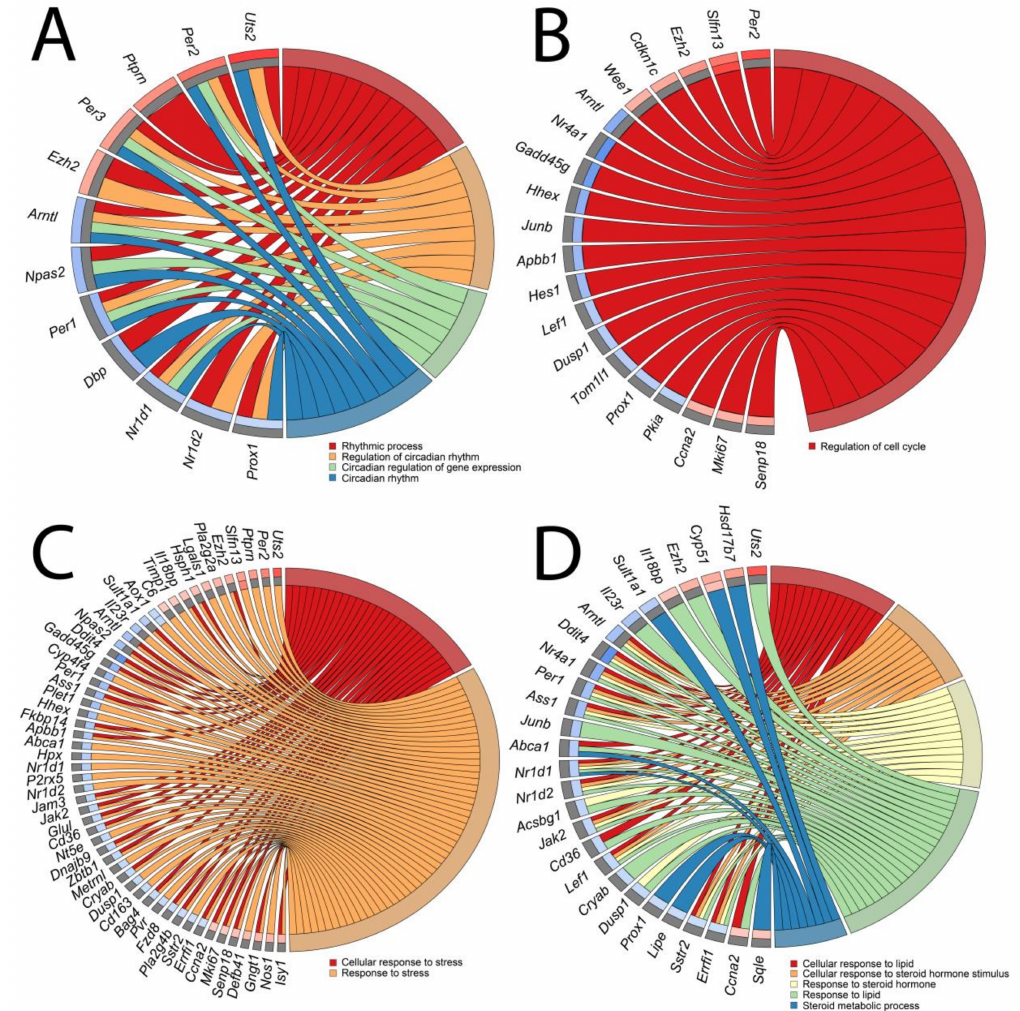
Figure 6. Circos plots of closely related GO terms (( A )—circadian rhythm, ( B )—cell cycle, ( C )—stress, ( D )—lipid and steroid) and differentially expressed genes belonging to relevant GO terms. Symbols of DEG are presented on the left side of the graph with their fold change values mapped by color scale (red = higher expression; blue = lower expression, gray = genes below the cut-off criteria with no statistical difference). Values of fold change are shown separately for 24 h vs. control (external rectangles) and for 72 h vs. control comparisons (internal rectangles). Gene involvement in the GO terms was determined by colored connecting